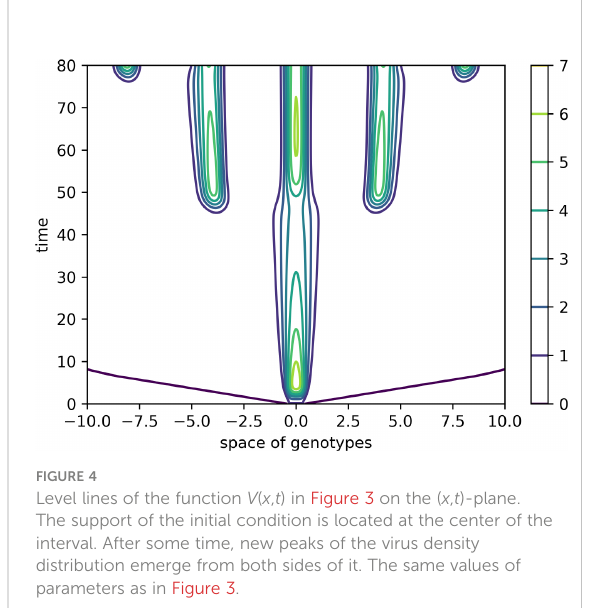
FIGURE 5 Solution V ( x , t ) of system (4.5) – (4.7) in consecutive moments of time. Different colors from blue to red correspond to increasing time. Initial condition is a piecewise constant function with the